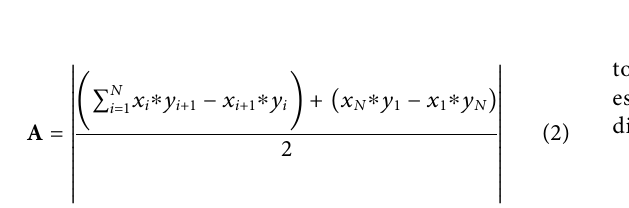
Frontiers in Robotics and AI |